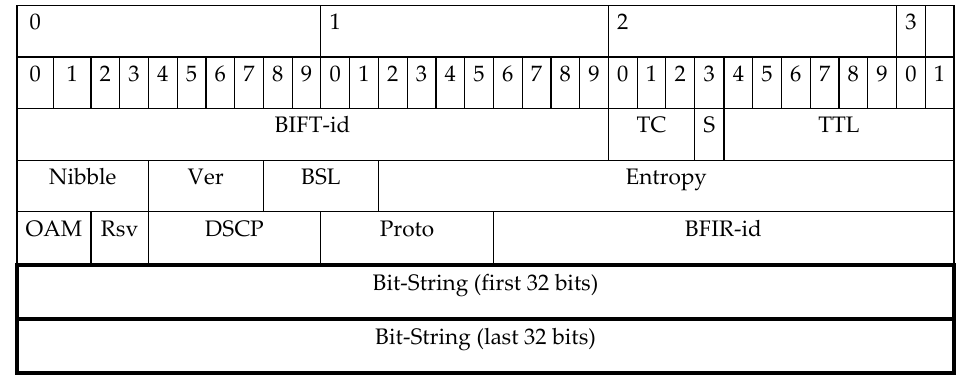
Figure 4. BIER header [51]. Sensors 2020 , 20 , x FOR PEER REVIEW